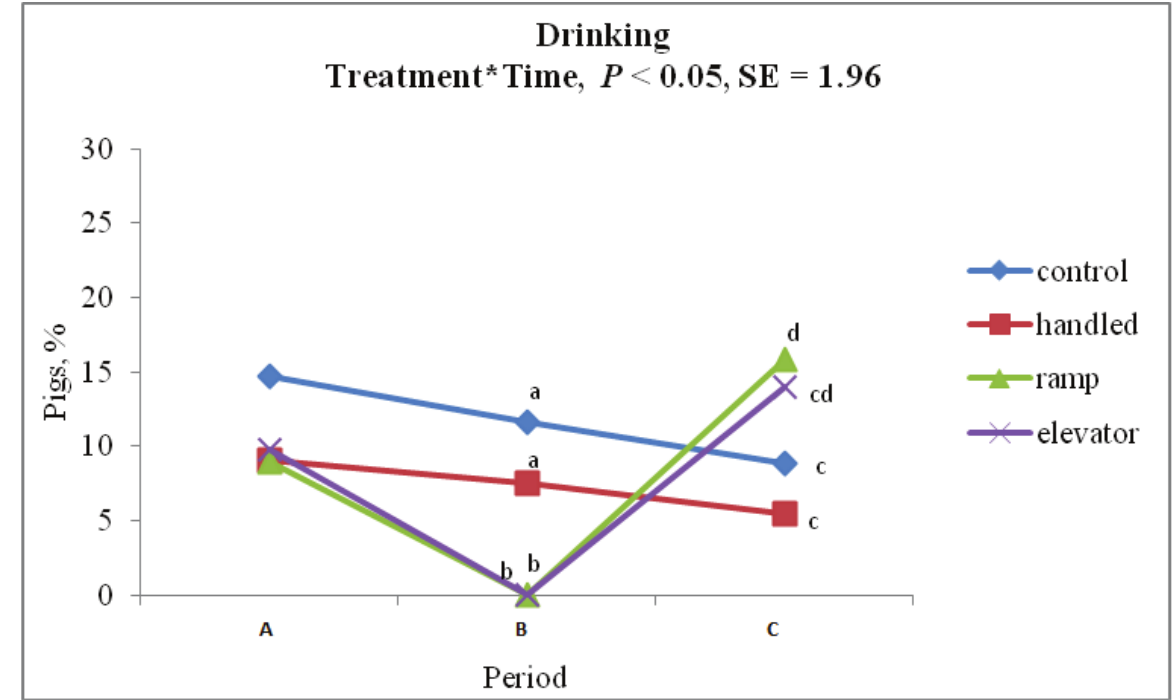
Figure 4. Percentage of pigs showing drinking behavior an hour before (A), during (B) and after (C) each treatment (control, handling, ramp and